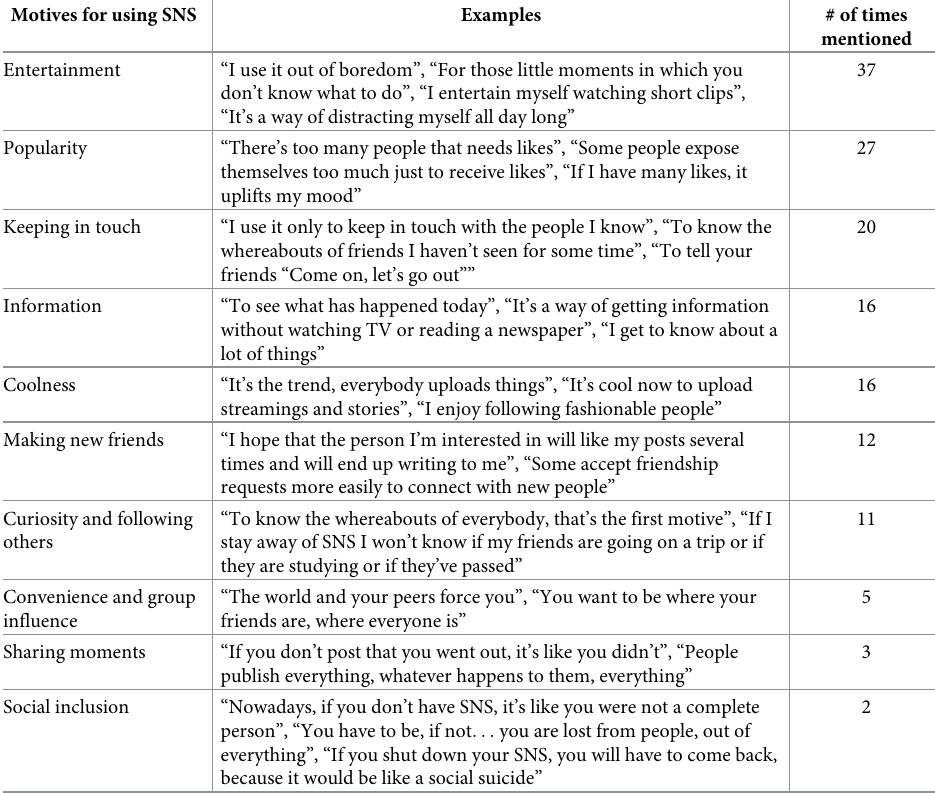
Table 3. Themes from focus groups and frequency of